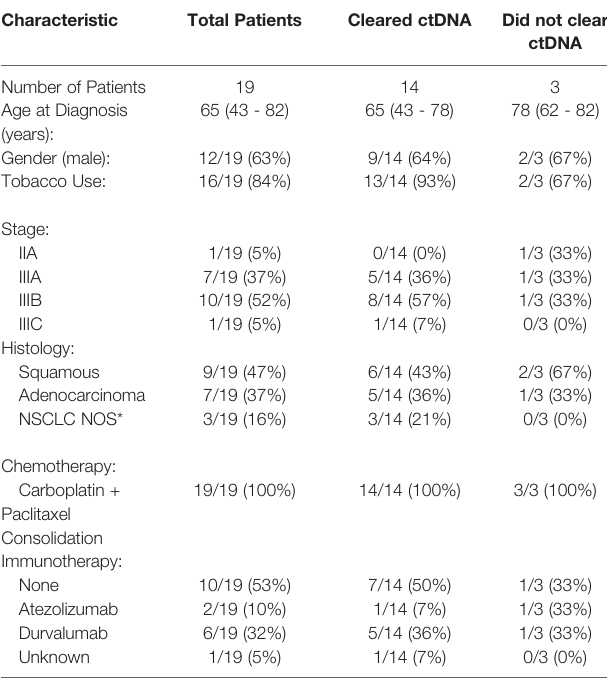
TABLE 1 | Baseline Characteristics.